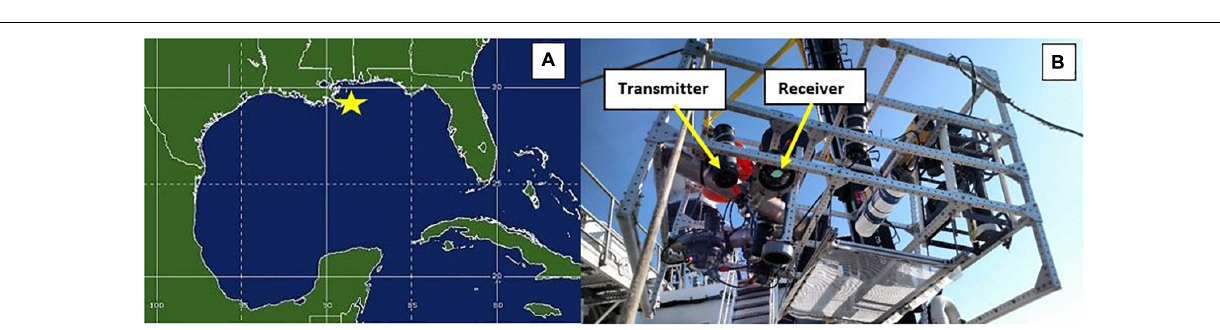
apart. For each station, an instrument cage was profiled from the surface to 300 m. Immediately after reaching 300 m sampling began and lasted 3 h. Periods for time series were aligned with dusk ascents and dawn descents of the DSL. The dusk migration was sampled at the first site, the dawn migration at the